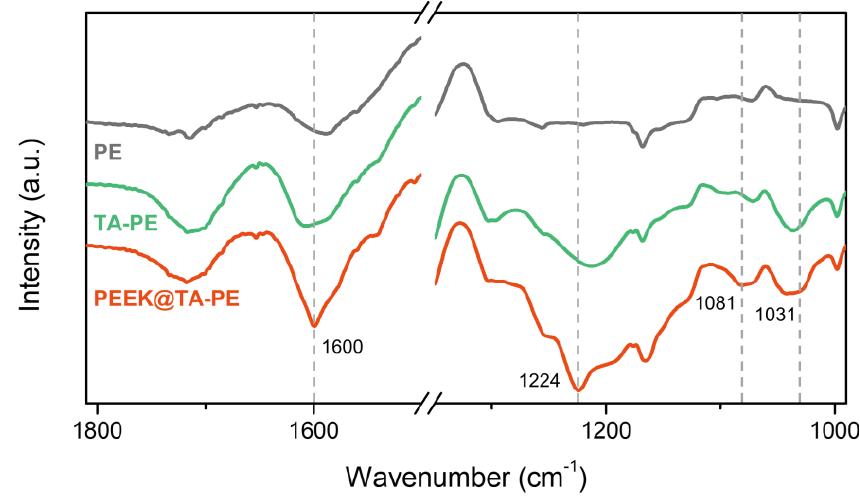
Figure 3. FT-IR spectra of the pristine PE, TA-PE, and PEEK@TA-PE separators.